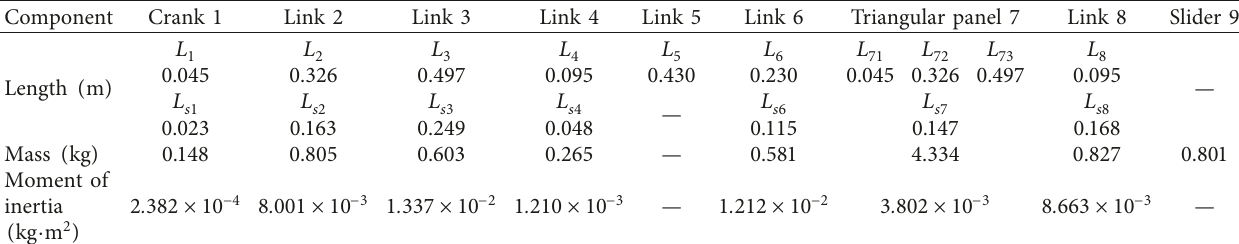
Table 1: Dimensions and mass properties for the 2-DOF nine-bar mechanism.